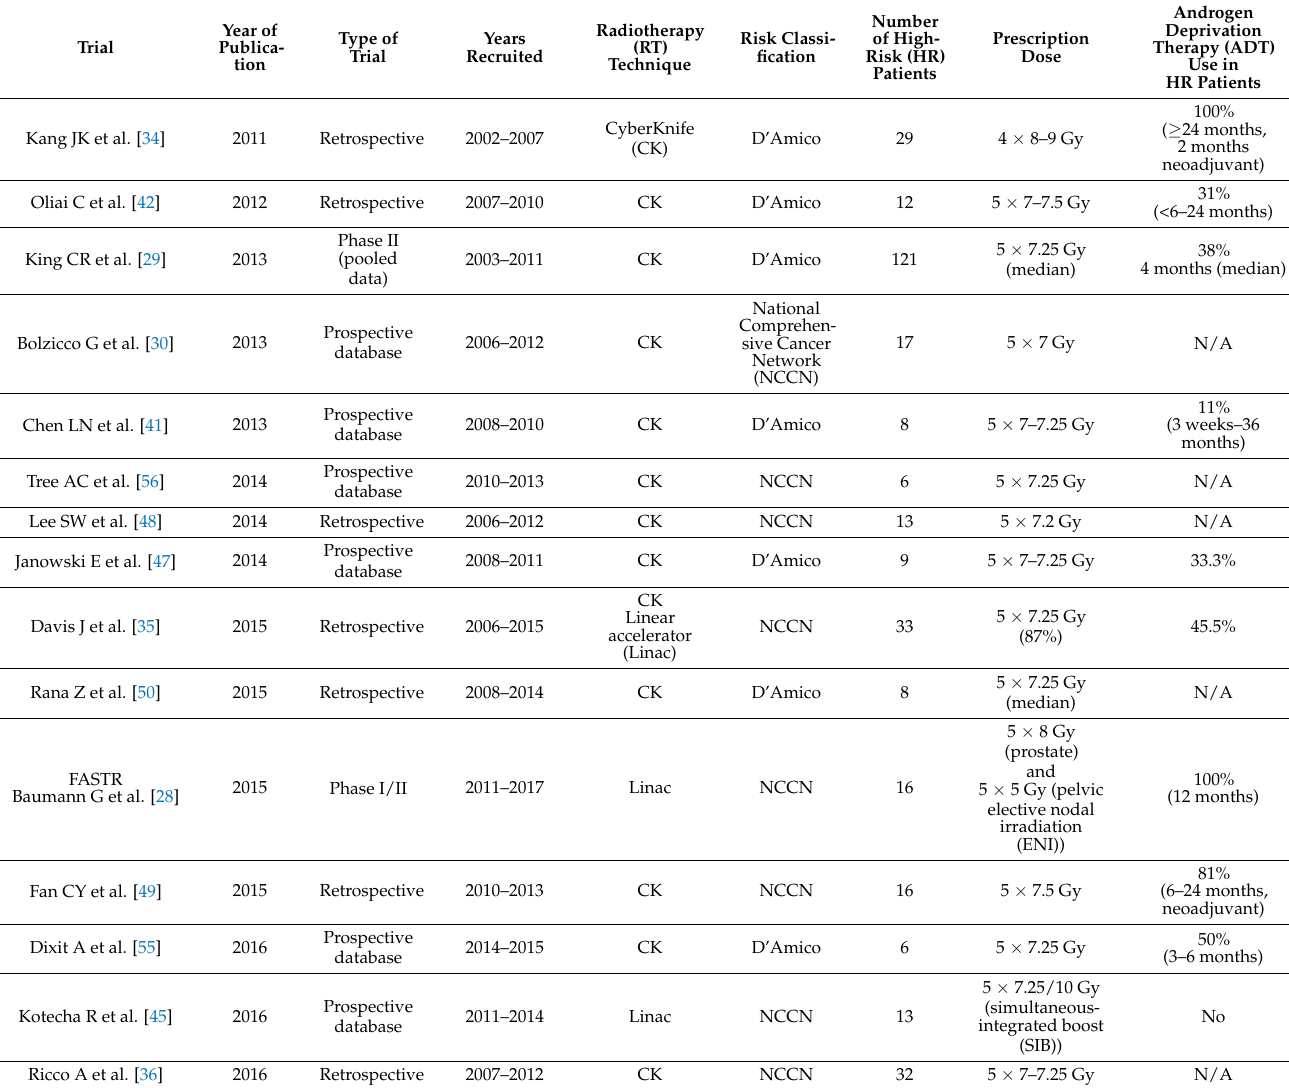
Table 1. Overview of included